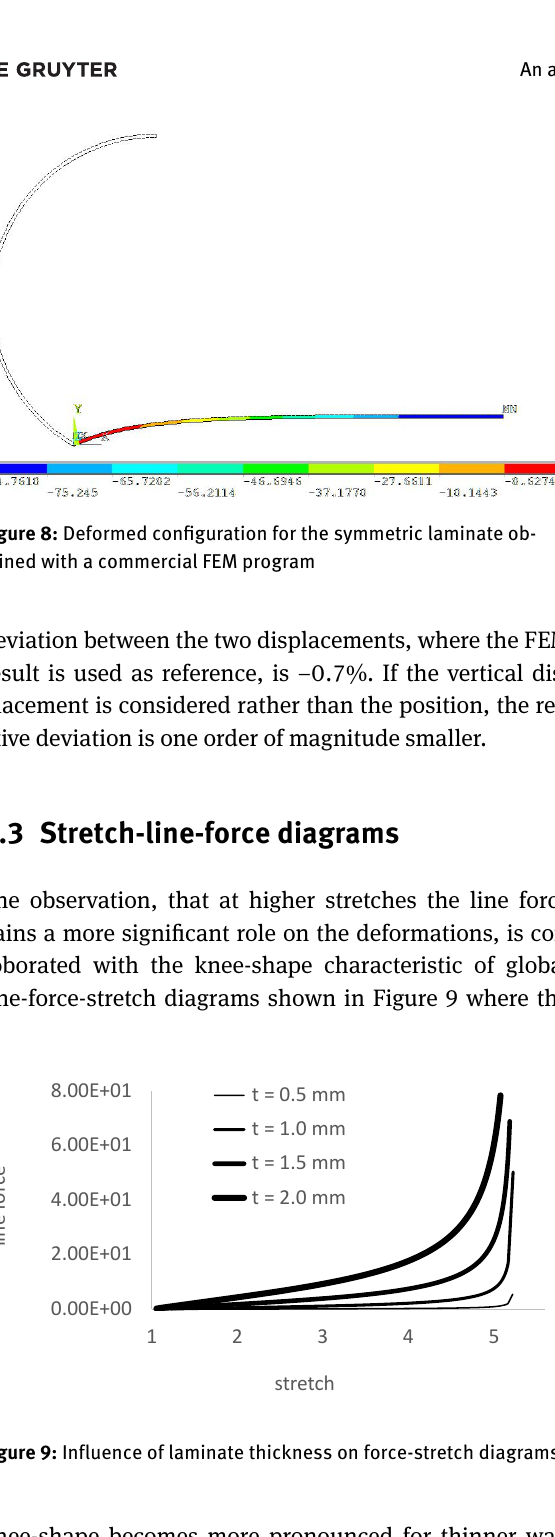
Figure 9: Influence of laminate thickness on force-stretch diagrams knee-shape becomes more pronounced for thinner wall thickness. Figure 10 shows the influence of corrugation amplitude c at the same thickness t = 1 mm . The diagrams indicate that not only the stretch limits reduce quickly but also that the average force required to approach the re- spective stretch limits increase significantly with decreas- ing corrugation amplitude.